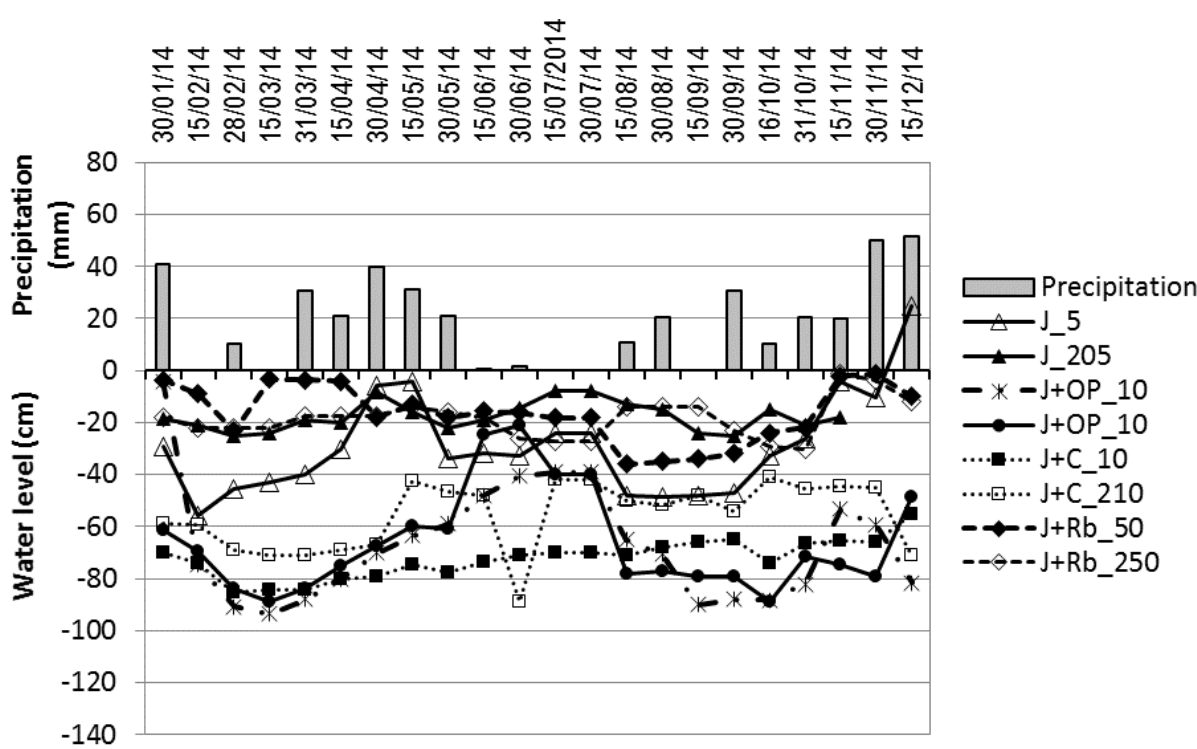
Figure 3. Water table level in the demonstration plots of ‘enrichment planting’ in Tanjabar, Jambi. J = ‘jelutung’, J+OP = ‘jelutung’+oil palm, J+C = ‘jelutung’+coffee+betel nut, J+Rb = ‘jelutung’+rubber. Numbers in the legend indicate distances from the front ditch. Approximately 2-week intervals from 30 Jan 2014 to 15 Dec